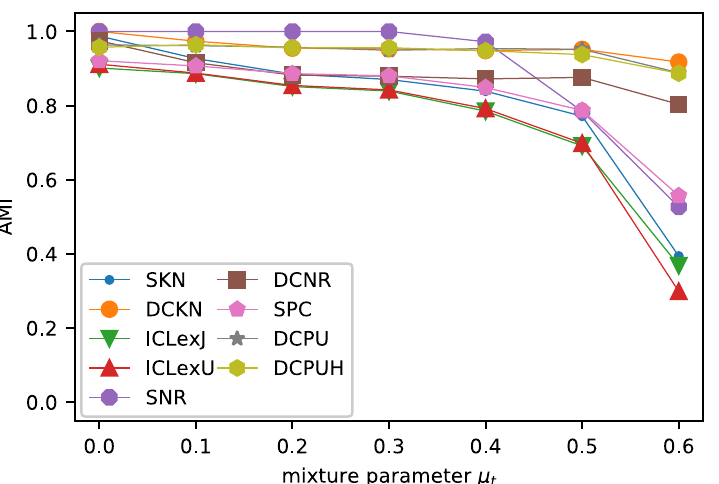
Fig 11. Results of LFR benchmark applied with the known number of groups. Each marker represents the average of 10 network instances. For each network each of inference algorithm (see Fig 12) were executed 10 times from random partition with the same number of blocks as the planted partition for each of the shown SBM variants. The AMI of the partition with the best objective value of all inference algorithms and all executions is used as result for the combination of network and model. Since the results of the DCP algorithm are the same as the SKN for the case without model selection, the diagram only includes the results of SKN.